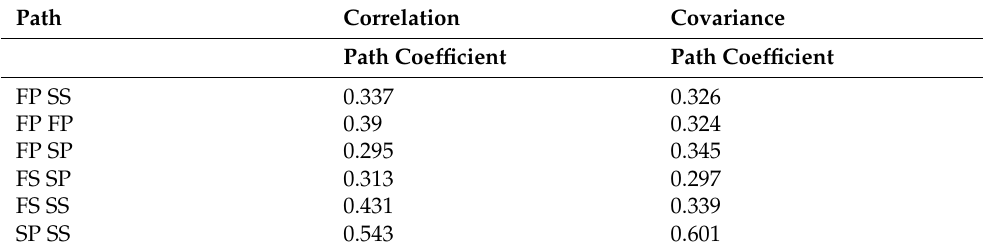
Table 5. Correlation and covariance.